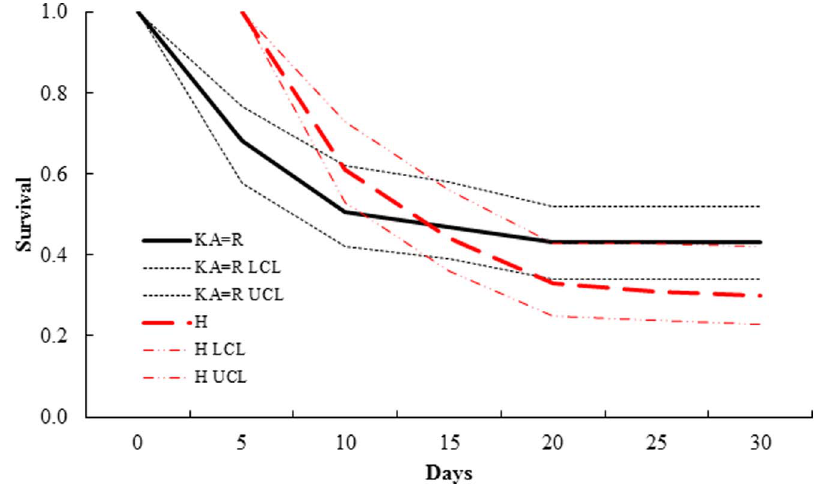
Figure 3. Candidate models of 30-day survival of mule deer ( Odocoileushemionus ) neonates in California, USA. Survival estimates up to 30 days from top-ranked model (KA=R, H) of mule deer ( Odocoileus hemionus ) neonates ( n =61), California, USA, 2005–2007. The top-ranked model indicated similar survival between known-age (KA) neonates and those aged using the Robinette (R) hoof-growth equation, which differed from neonates aged using the Haskell (H) hoof-growth equation. Equations were obtained from Haskell [17] and Robinette